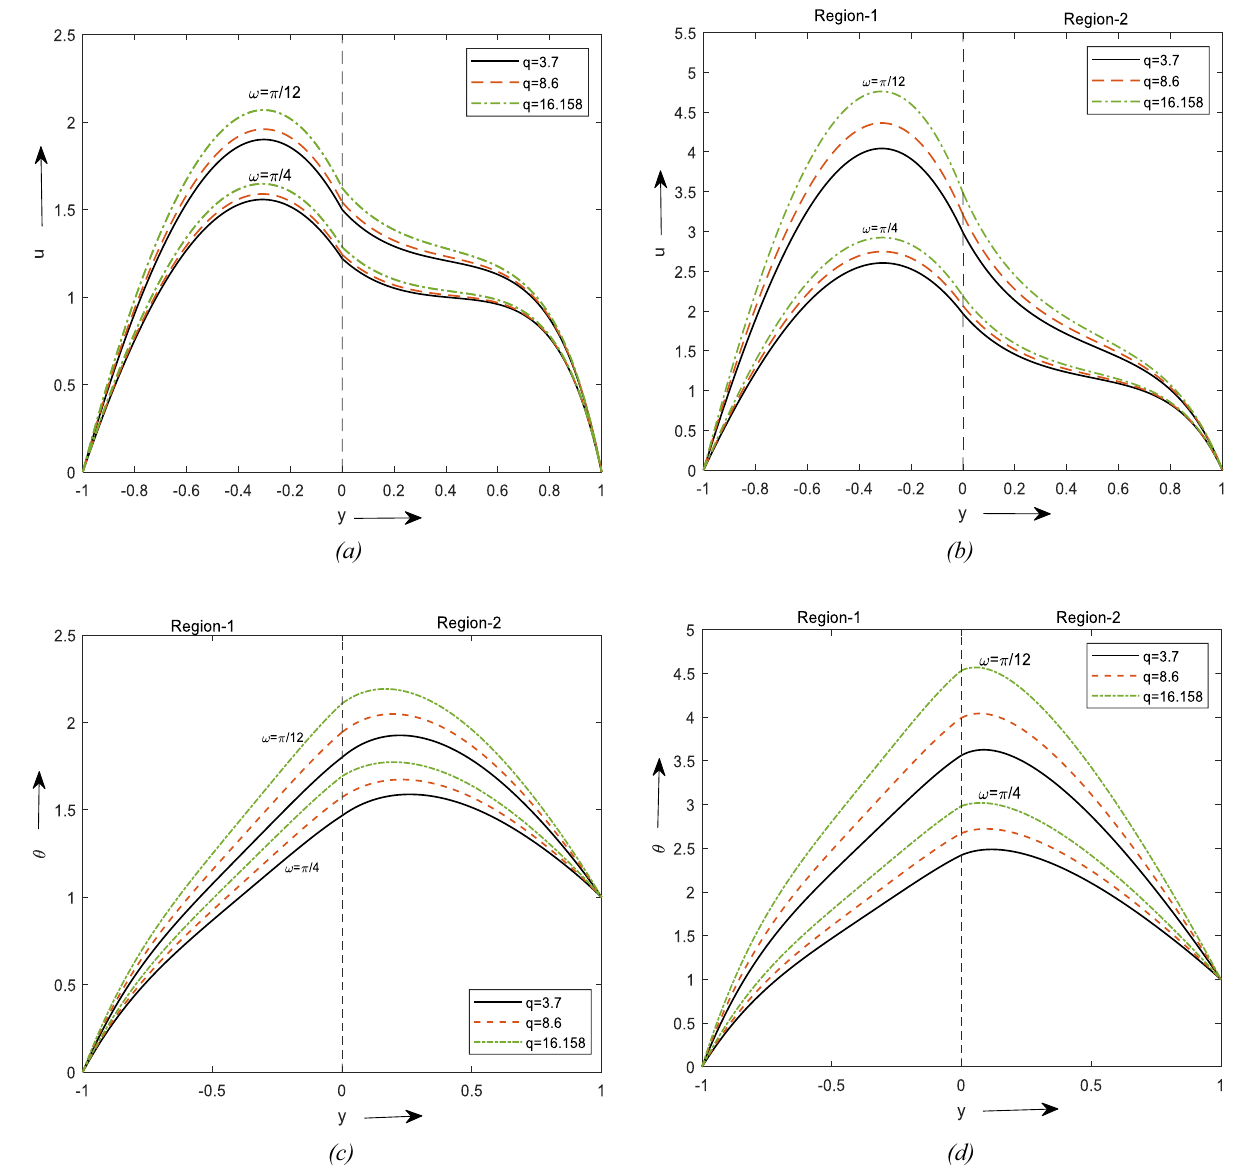
Figure 4. Velocity profiles for different values of ω . ( a ) For two different values of φ . ( b ) For a value of φ . Temperature profiles for different values of ω . ( c ) For two different values of φ . ( d ) For a value of φ